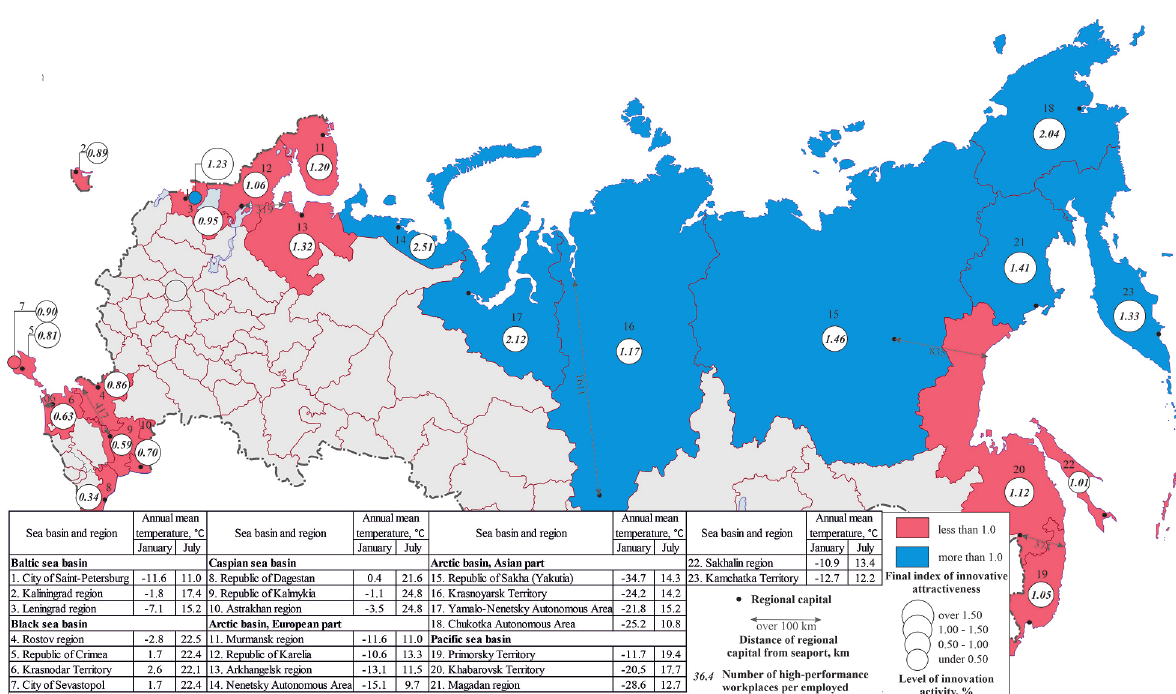
Fig. 2. The innovation performance of the coastal regions of Russia,